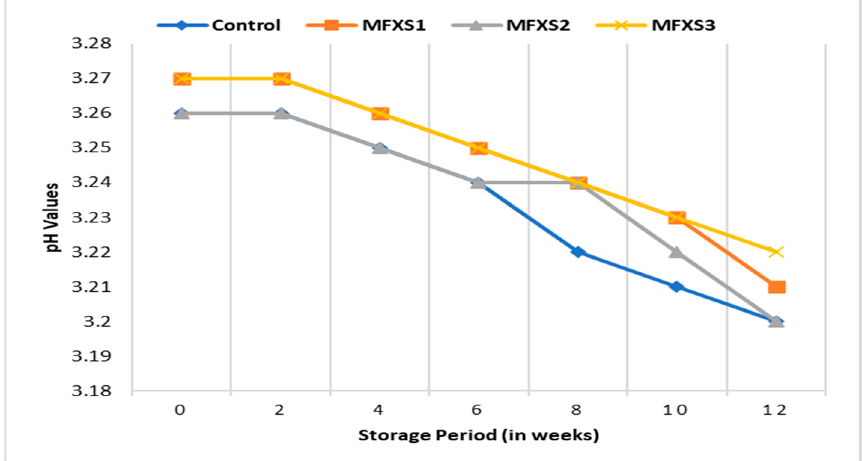
Figure 2. pH values of mayonnaise samples during cold storage (7 ± 2 °C). Control sample: 70% soy bean oil, MFXS1: 20% flaxseed oil and 50% soy bean oil, MFXS2: 30% flaxseed oil and 40% soy bean